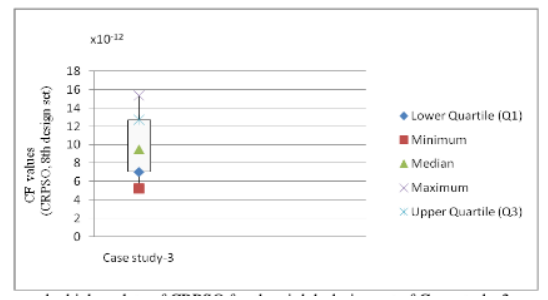
Figure 15: Box and whisker plots of CRPSO for the eighth design set of Case study-3 over 50 trial